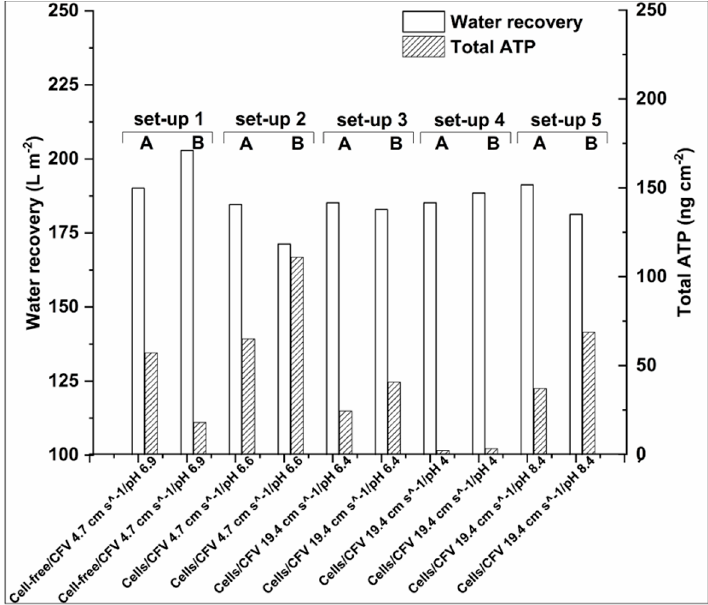
Figure 4. Water recoveries (white columns) and the corresponding Total-ATP concentration (shaded columns) after 22 h of FO operation. The letters A and B correspond to the replications of the experiments.